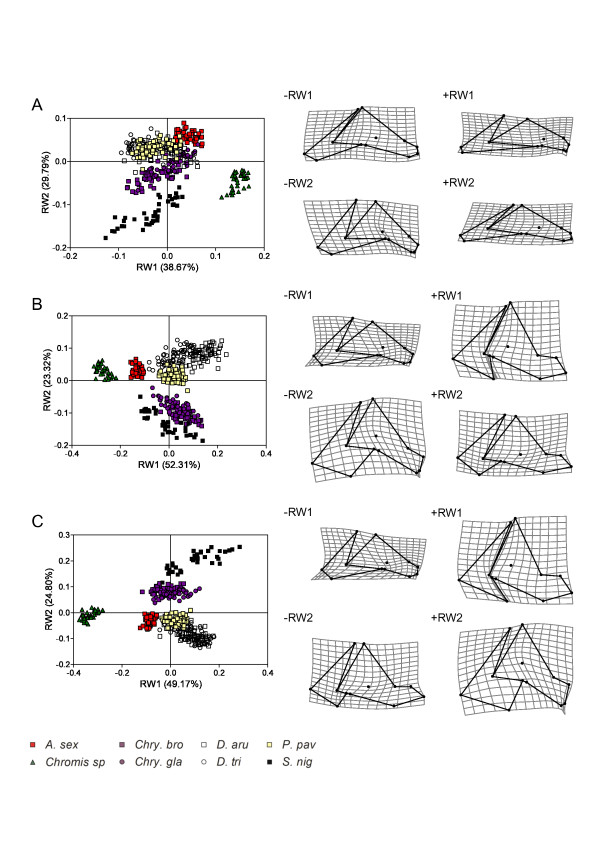
Ontogenetic dynamics of the patterns of mandible shape disparity. Relative warps analyses of the mandible shapes at the three ontogenetic stages. A, shapes at the settlement stage. B, shapes at an intermediate size of 60 mm SL. C, shapes at the maximum adult body size. TPS deformation grids indicate shape variation represented by RW1 and RW2 (minimal (-RW) and maximal (+RW) values).